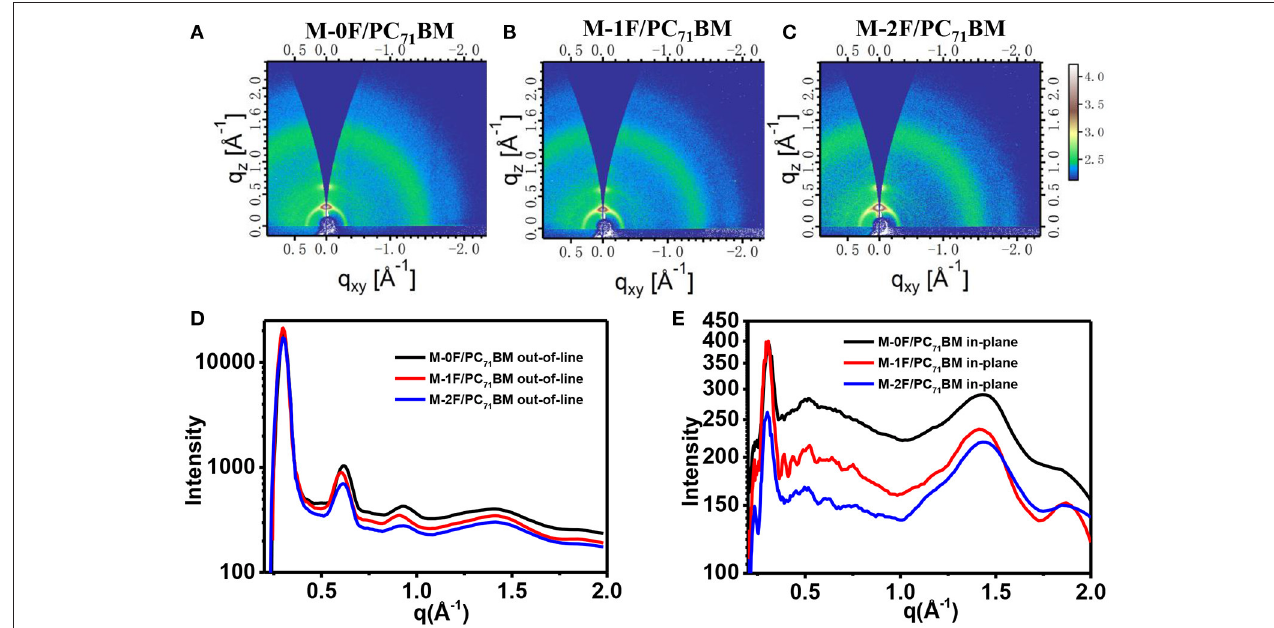
FIGURE 5 | 2D GIWAXS patterns of M-0F/PC 71 BM (A) , M-1F/PC 71 BM (B), and M-2F/PC 71 BM (C) blend film. Out-of-plane (D) and in-plane (E) cuts of the corresponding 2D GIWAXS patterns.